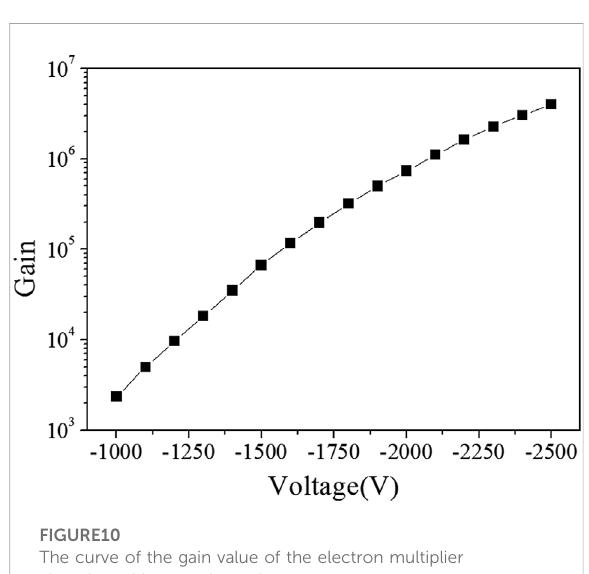
The curve of the gain value of the electron multiplier changing with operating